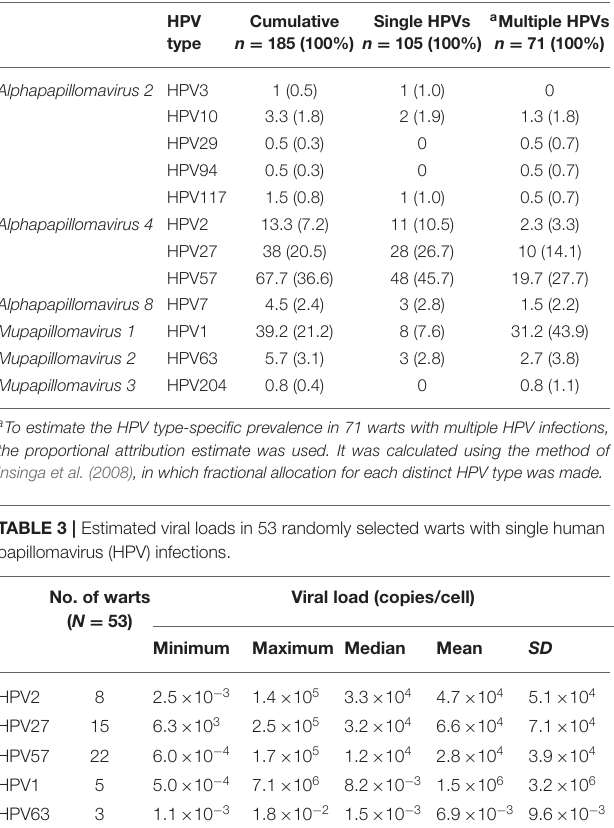
TABLE 2 | Prevalence of human papillomavirus (HPV) types in 185 common warts of immunocompetent patients.